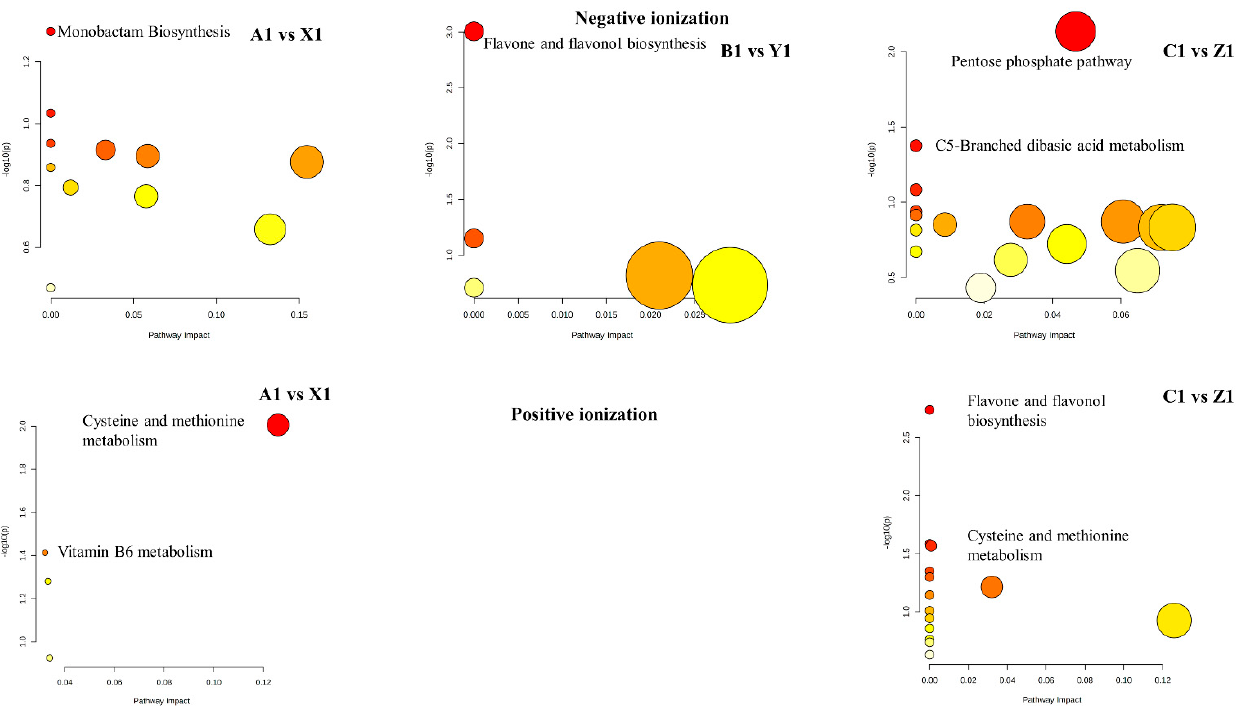
Figure 6. All matched pathways according to the p values from the pathway enrichment analysis and pathway impact values from the pathway topology analysis. The compound color within the pathway ranges from yellow to red, indicating different levels of significance of metabolites in the corresponding pathway. Circle size indicates the pathway impact score. SB-DT2 (C1 vs. Z1) enriched with more metabolic pathways than other genotypes. Corresponding pathways and their p -values are provided in Table S7. Table 3. Significant metabolic pathway with p < 0.05 across the genotype comparisons.